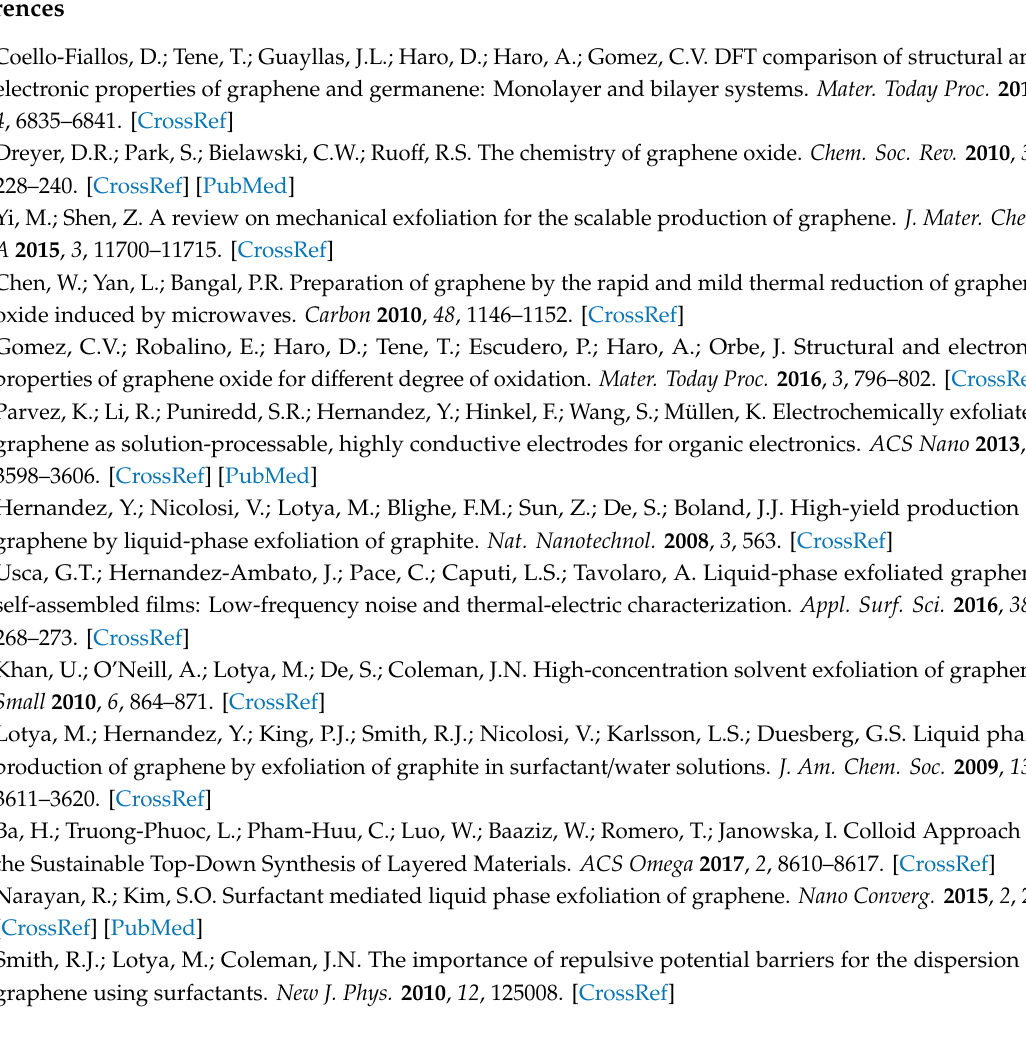
Figure S1: Obtained graphene dispersions (12 weeks stored) after hydrothermal treatment (HT), 3 h of sonication and centrifugation, in the three di ff erent concentrations of CTAB (0.1, 0.5, and 1.0 mg mL − 1 ) reported in the main text. After sonication, the obtained suspensions were left to stand overnight and then centrifugated for 90 min at 2000 rpm., Figure S2: Schematic route of the preparation process for FLG dispersions. Natural graphite flakes are added into CTAB aqueous solution (at di ff erent surfactant concentrations: 0.1, 0.5, and 1.0 mg mL − 1 ). The resulting mixture is reacted at 180 ◦ C for 15 h. The obtained pretreated graphite is immediately dispersed in the very same CTAB aqueous solution by sonication, Figure S3: Scanning electron microscopy (SEM) morphology of dispersed graphene layer in 1.0 mg mL − 1 of CTAB aqueous solution, by changing the accelerating voltage from 5 to 30 kV. Semitransparent layer extracted from supernatant after HT, 3 h of sonication, centrifugation for 90 min at 2000 rpm, and dried at 235 ◦ C, Figure S4: Raman spectrum of the 2D peak of dispersed graphene in 0.1 mg mL − 1 of CTAB aqueous solution and fitting of the 2D peaks with two Lorentzian functions. The w values represent the respective full width at half maximum (FWHM) values, Figure S5: Raman spectrum of the 2D peak of dispersed graphene in 0.1 mg mL − 1 of CTAB aqueous solution and fitting of the 2D peaks with one Lorentzian function. The w value represents the respective FWHM